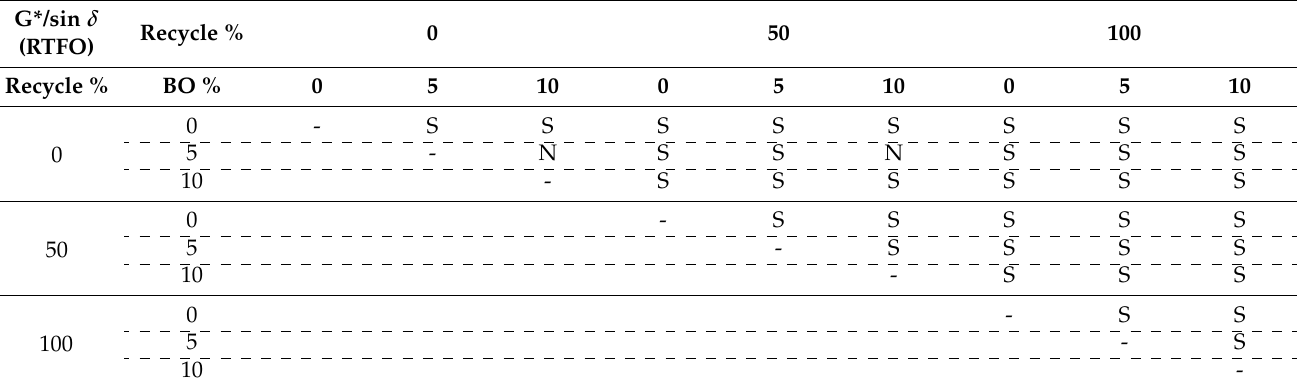
Table 5. Statistical analysis results of the G*/sin δ for RTFO condition as a function of aged binder contents and the addition of base oil ( α = 0.05).